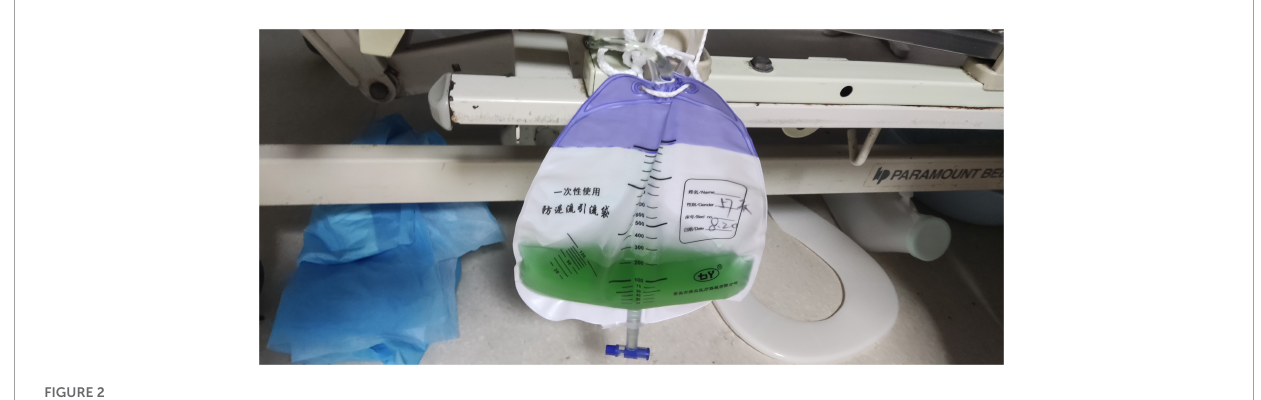
FIGURE2 The urine color after administering methylene blue.